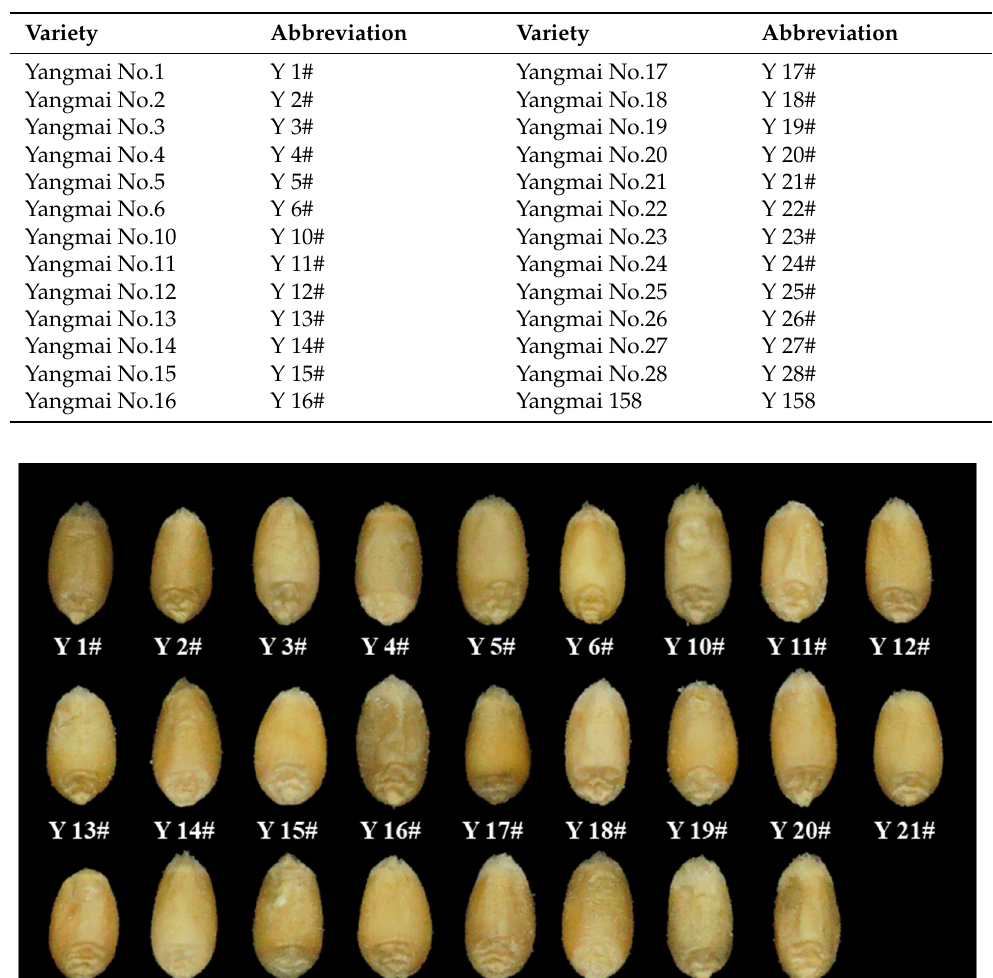
Table 1. Yangmai series variety name and abbreviation.